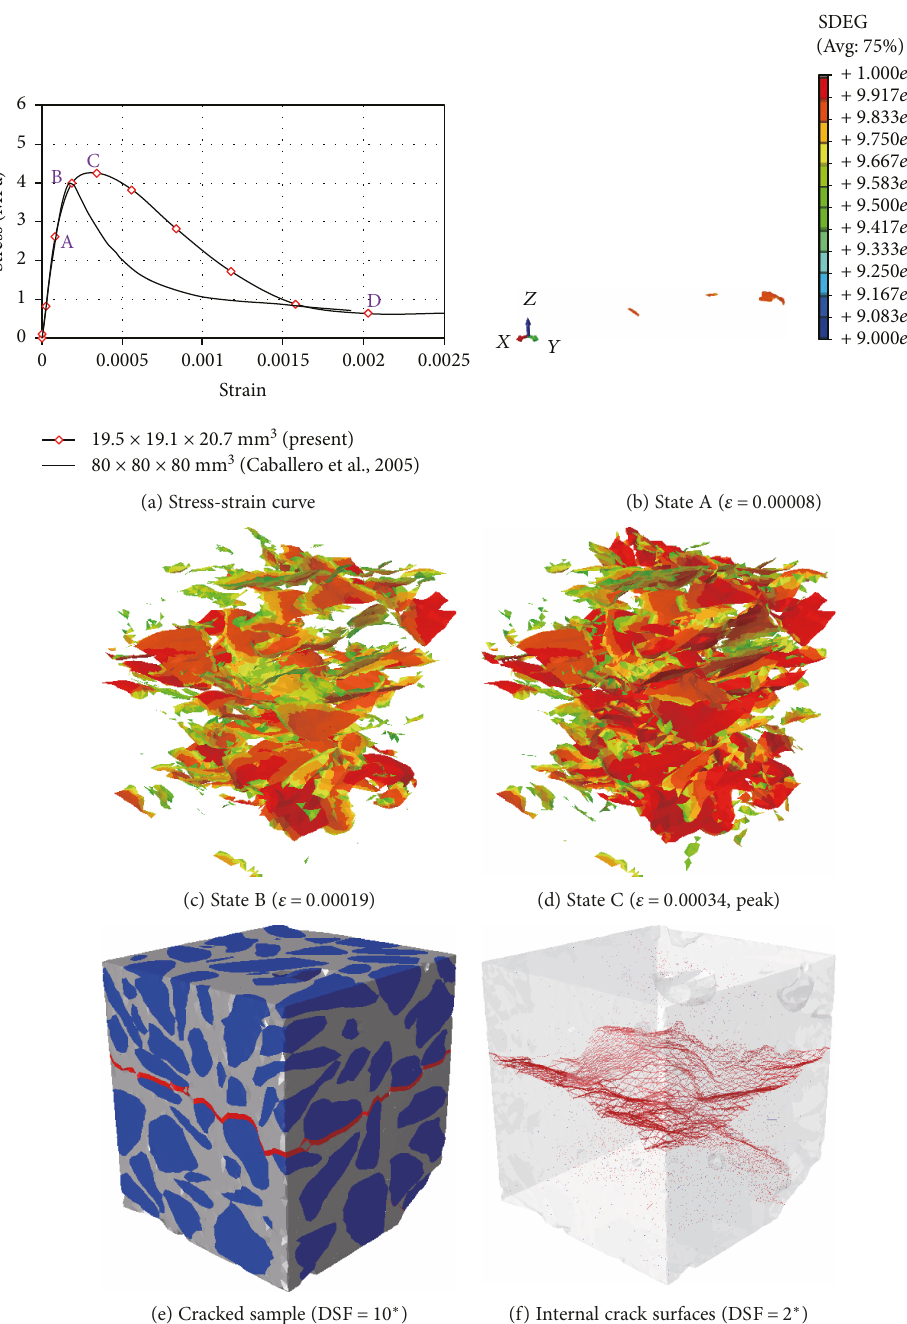
Figure 13: Stress-strain curve and damage propagation under tension. ∗ DSF is displacement scale